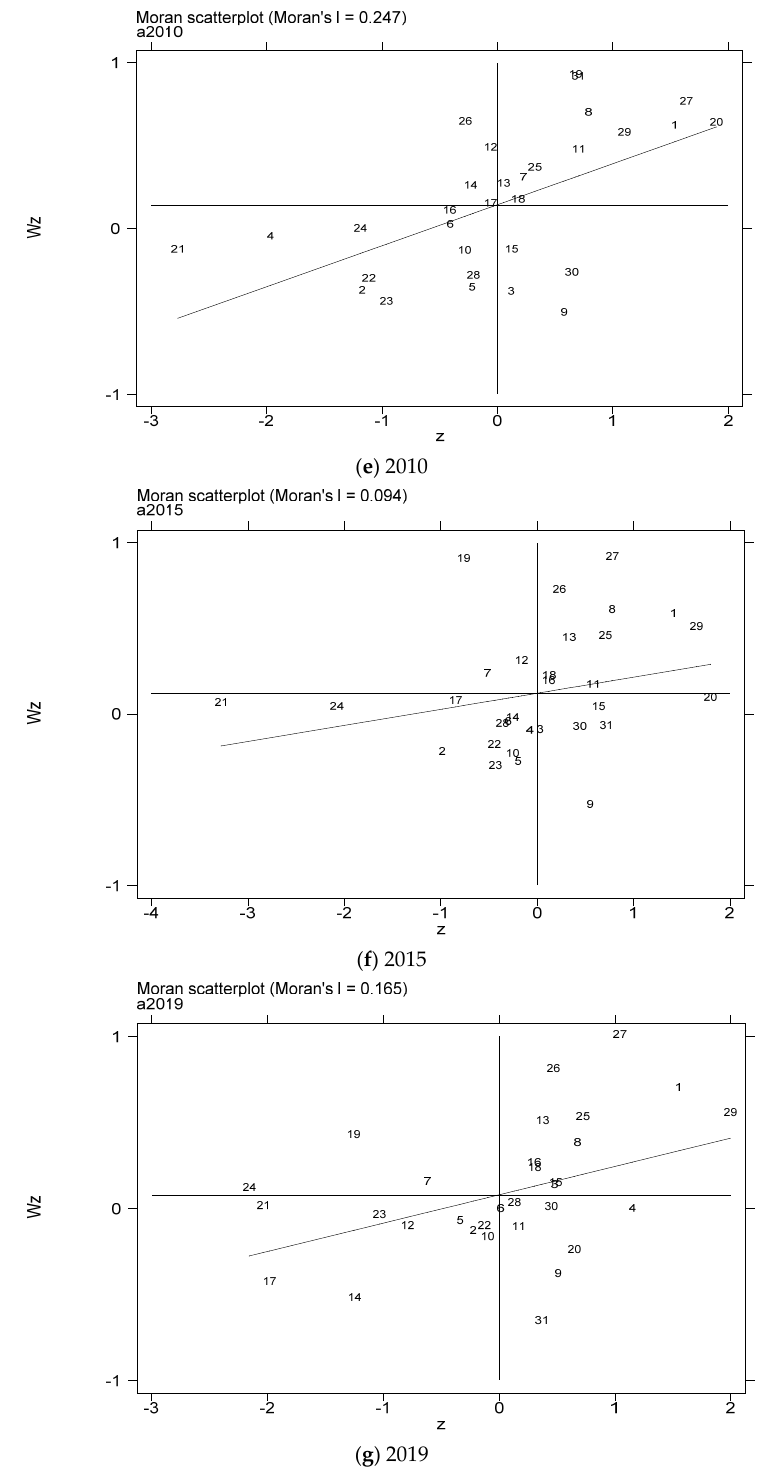
Figure 5. Scatter plot of local Moran index of the coupling coordination degree of China’s industrial- ization and agricultural green development in some years ( a – g ). (a) 1990; ( b ) 1995; ( c ) 2000; ( d ) 2005; ( e ) 2010; ( f ) 2015; ( g ) 2019. Data Source: the authors calculated based on China Statistical Yearbook, China Industrial Statistical Yearbook, China Rural Statistical Yearbook, China Regional Economic Statistical